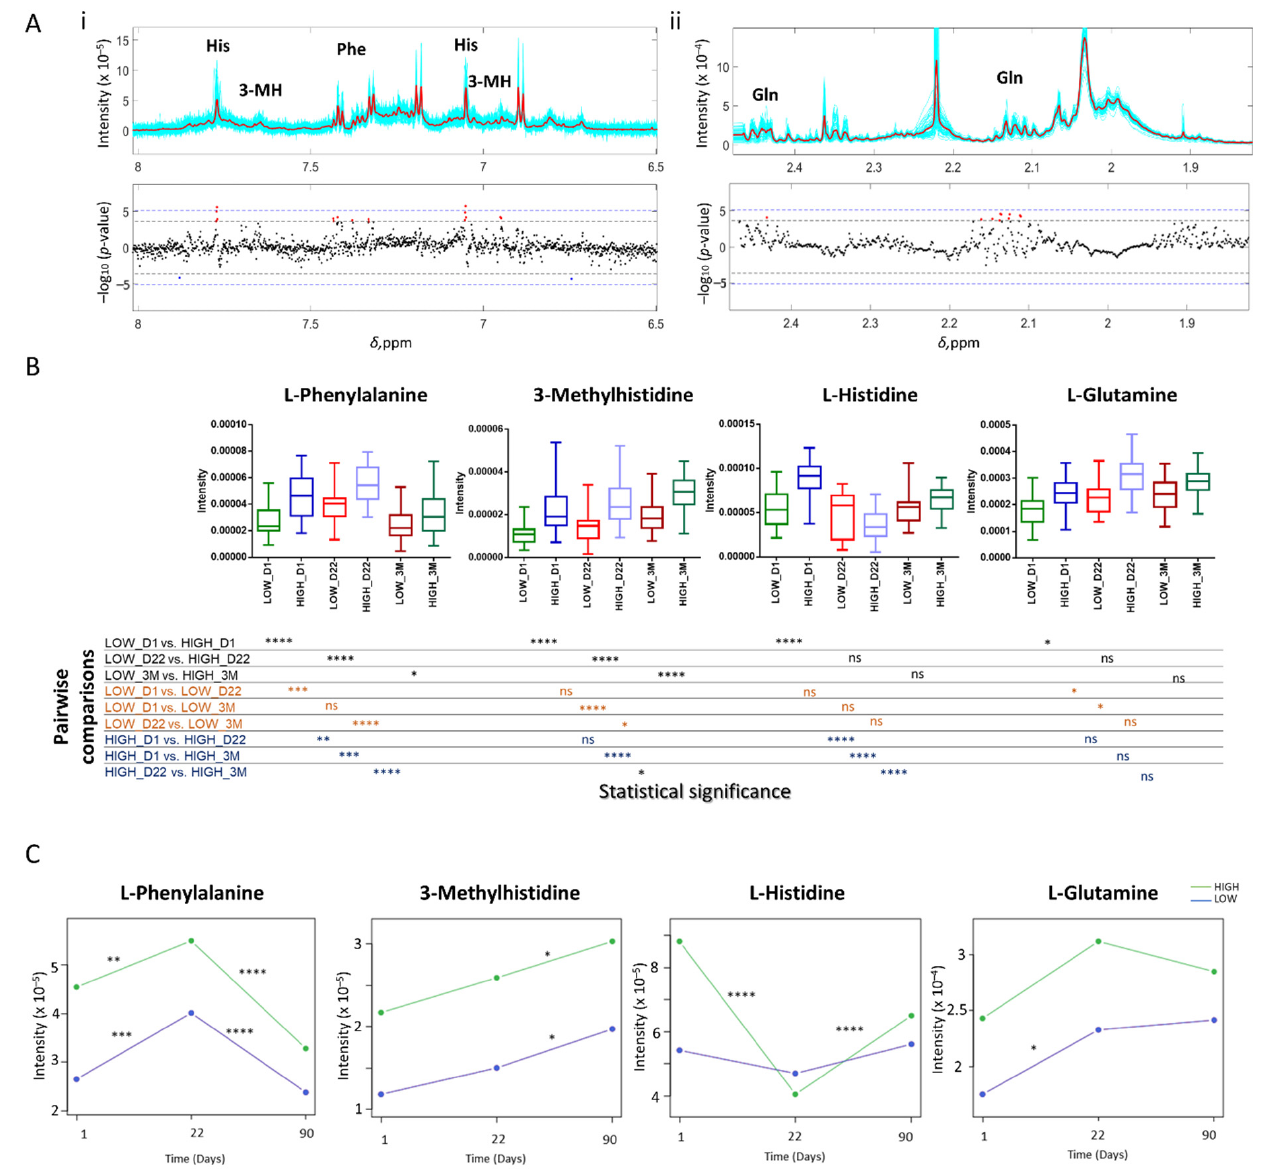
Figure 1. Correlation of NMR metabolic features with immune response. ( A ) Manhattan-type plot showing the analysis of the 6555 CPMG NMR features with response at day 22. The signed − log 10 ( p -value) is derived from Spearman correlation analysis with adjustment for age and sex. The dotted lines represent the threshold after multiple Bonferroni testing correction (blue line, p -value < 1.8 × 10 − 5 ) or FDR (black, p -value < 2.3 × 10 − 4 ), and the red dots represent the data points that remain significant after FDR. The horizontal axis is the NMR chemical shift (in ppm). In the upper panel, the 58 spectra (cyan) and their means (red) are depicted. Associations with ( i ) L -histidine (His), L -phenylalanine (Phe) and 3-methylhistidine (3-MH) and ( ii ) L -Glutamine (Gln) are shown. ( B ) Boxplots of the significant metabolites at all the 3 time points. In black, comparison of low vs. high responders within each time point. In orange, comparison between the three time points in the low responders group. In blue, comparison between the three time points in the high responders group. ( C ) Longitudinal change of the significant metabolites among the three time points. Asterisks indicate statistical significance using ANOVA: **** p < 0.0001, *** 0.0001 < p < 0.001, ** 0.001 < p < 0.01, * 0.01 < p < 0.05, ns: no significance.